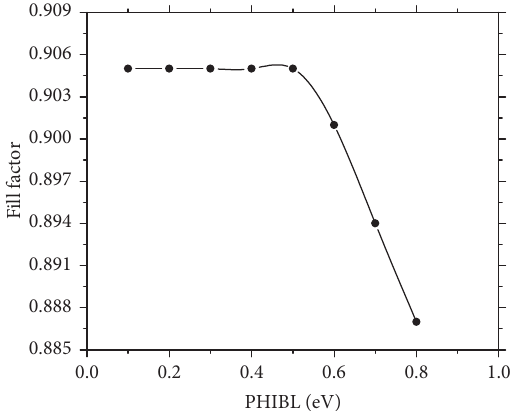
Figure 8: PHIBL versus fi ll factor plot of the proposed solar cell ’ s back contact.